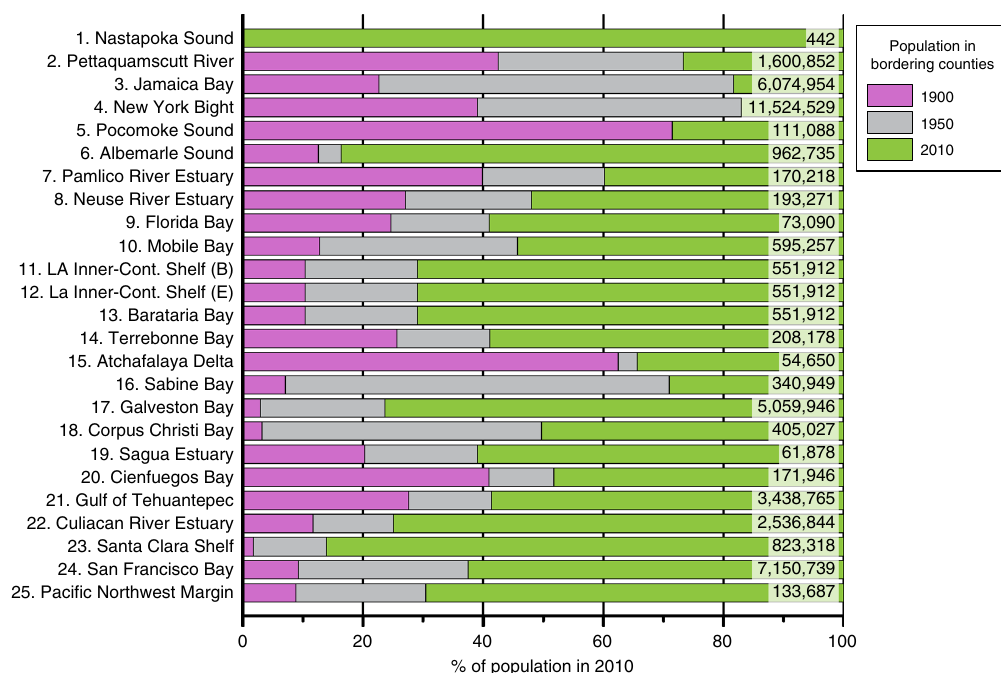
Fig. 2 Coastal population growth since 1900. The coastal population of counties adjacent to the sites increased sharply around 1950. Population data adjacent to Nastapoka Sound is only available for 2010. Population of counties adjacent to Pocomoke Sound decreased 2% in 1950. All populations in 2010 are enumerated. Data and sources provided in Supplementary Data 1.